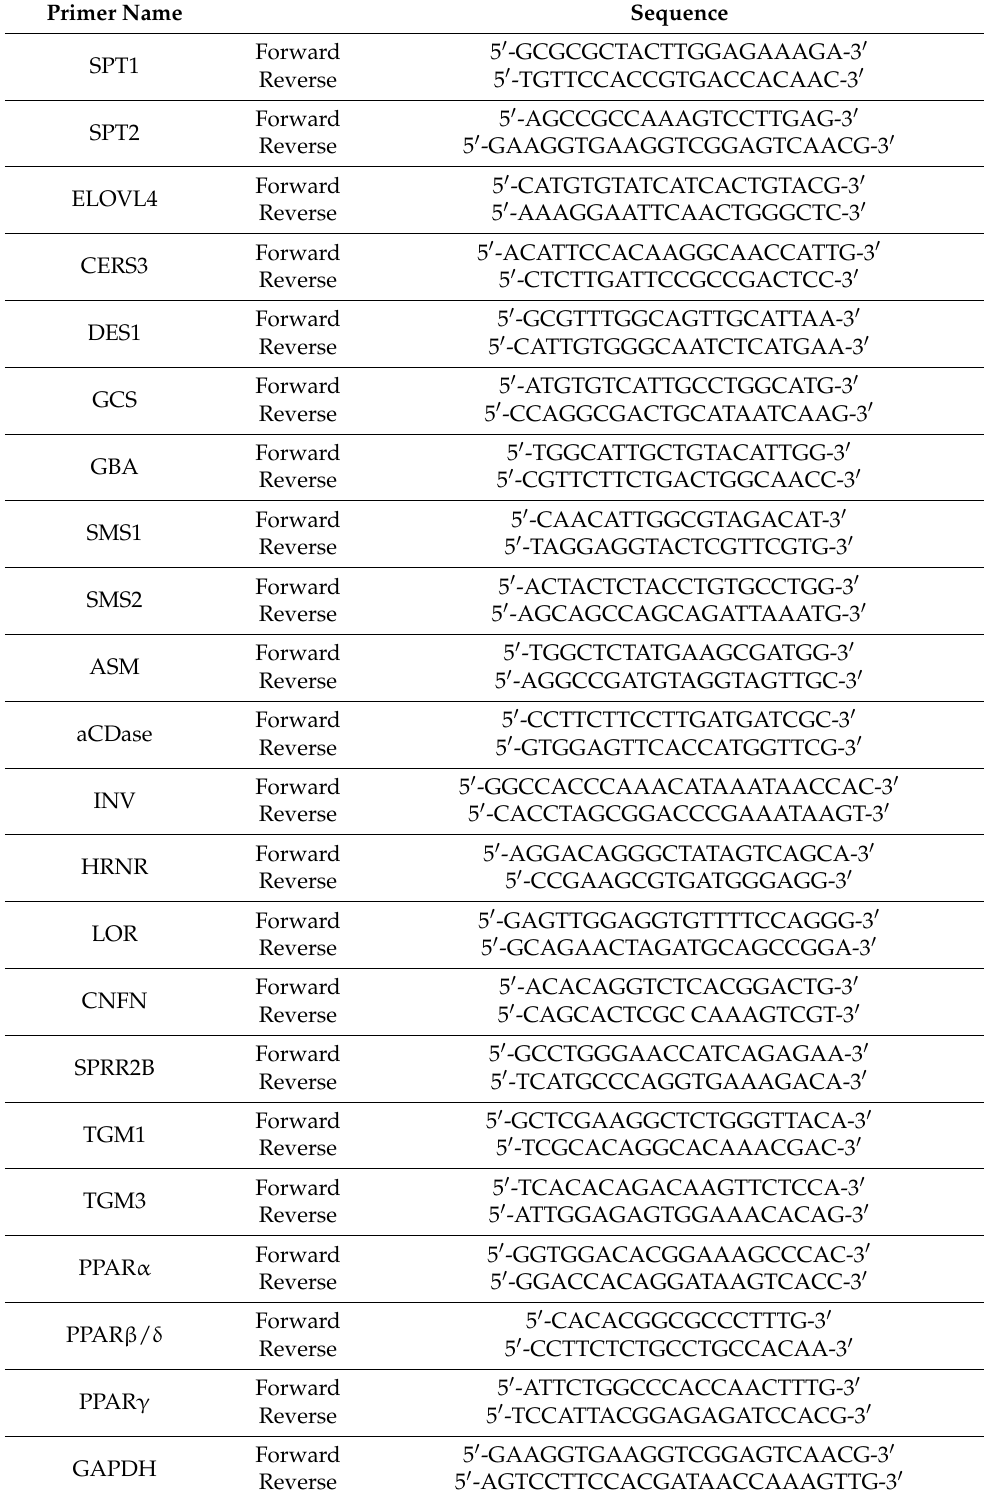
Table 1. RT-PCR primer